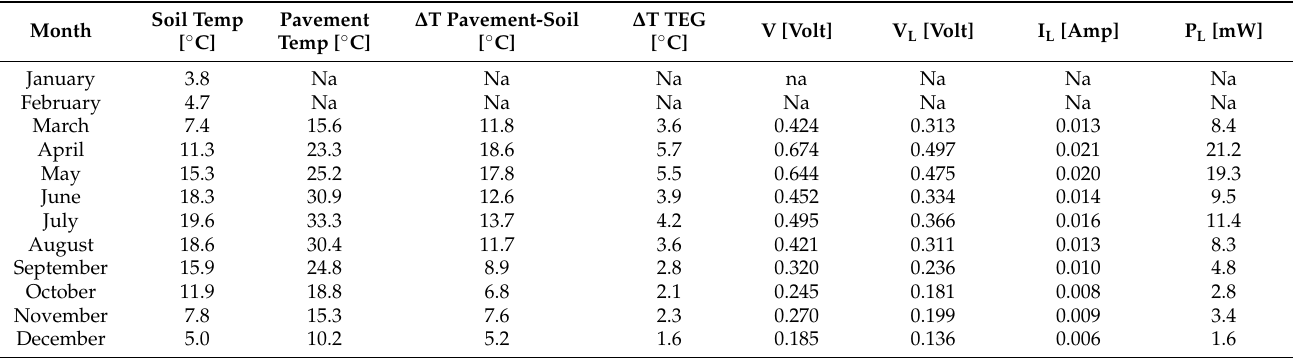
Table 5. Calculated voltage and power corresponding to each